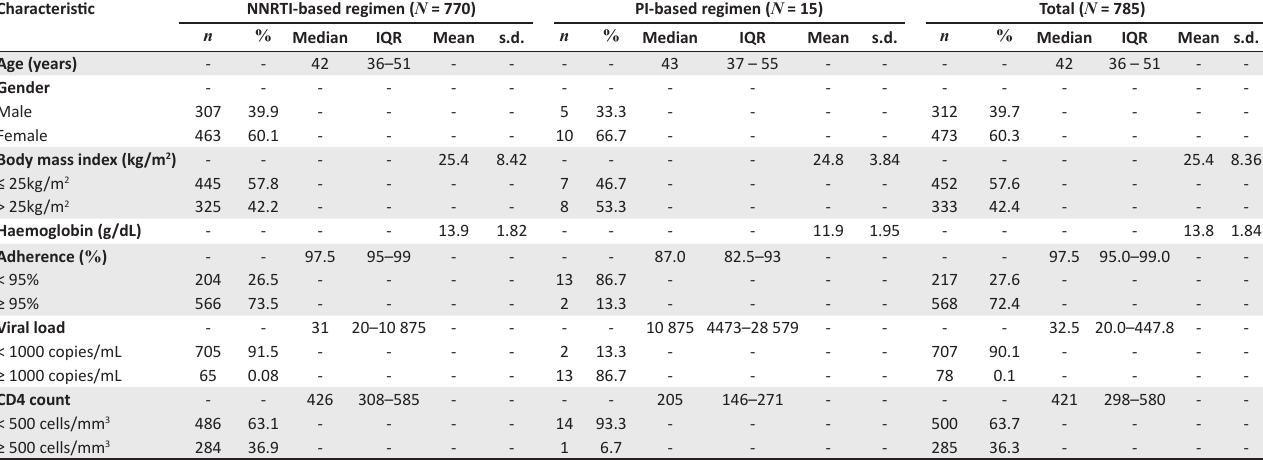
TABLE 2: Description of the demographic and clinical characteristics of the study participants by antiretroviral treatment regimen. Characteristic